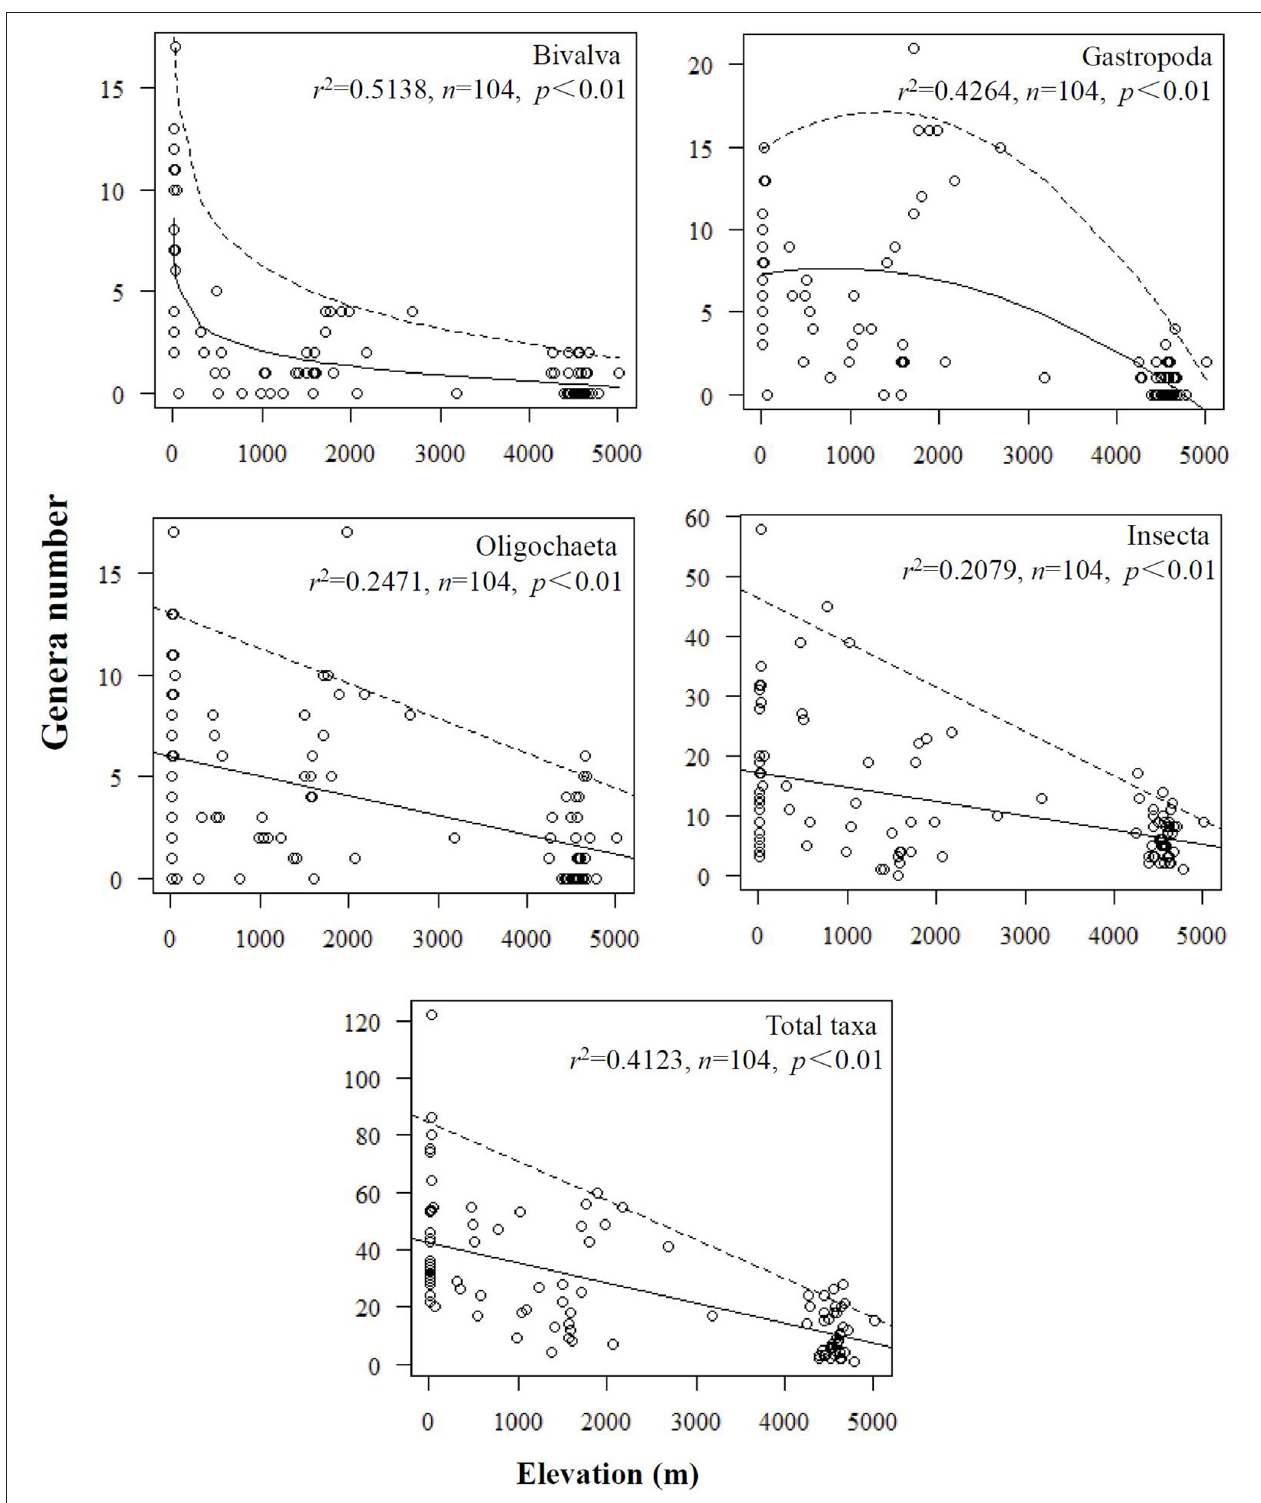
FIGURE 4 | Biodiversity patterns along elevational gradient in different groups of benthic macroinvertebrates in lakes of China and India. Oligochaetes, gastropods, and bivalves were identified to genus or species. Insects were identified to family or genus. The solid lines represent the best regression curve using the least-squares method (statistical significance of r 2 values is shown). The dashed lines represent the quantile regression curve of 95th percentiles.